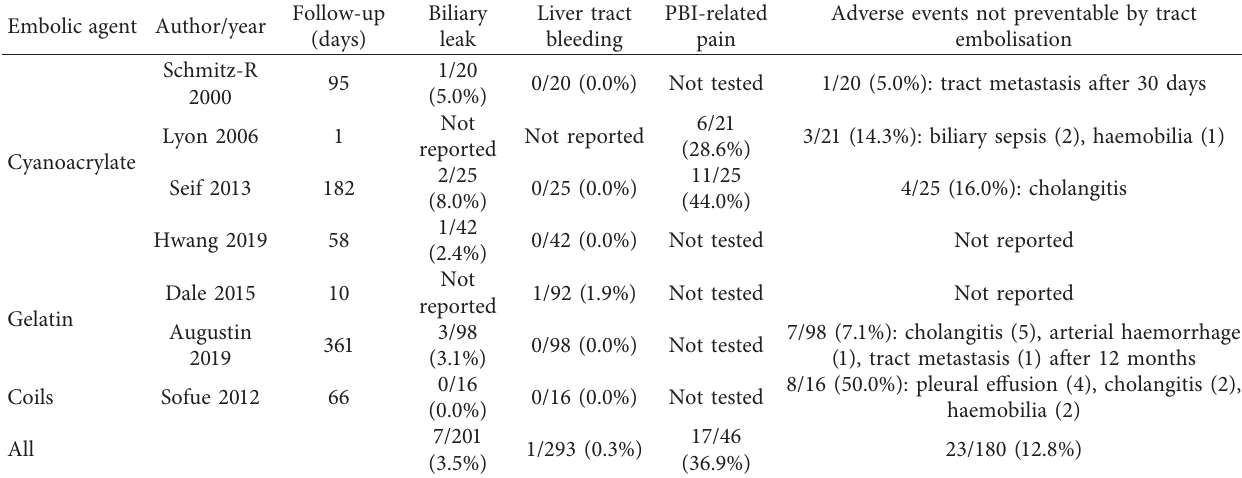
Table 3: PBI-related adverse events after percutaneous biliary intervention, preventable by transhepatic tract embolisation or not. The follow-up period in days (median).